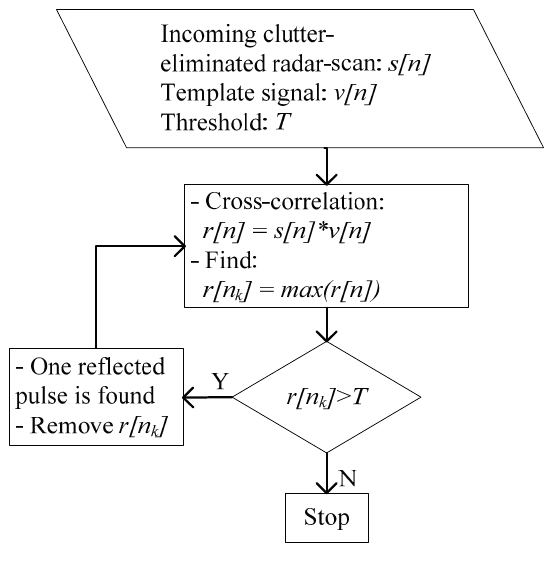
Figure 2. CLEAN detection